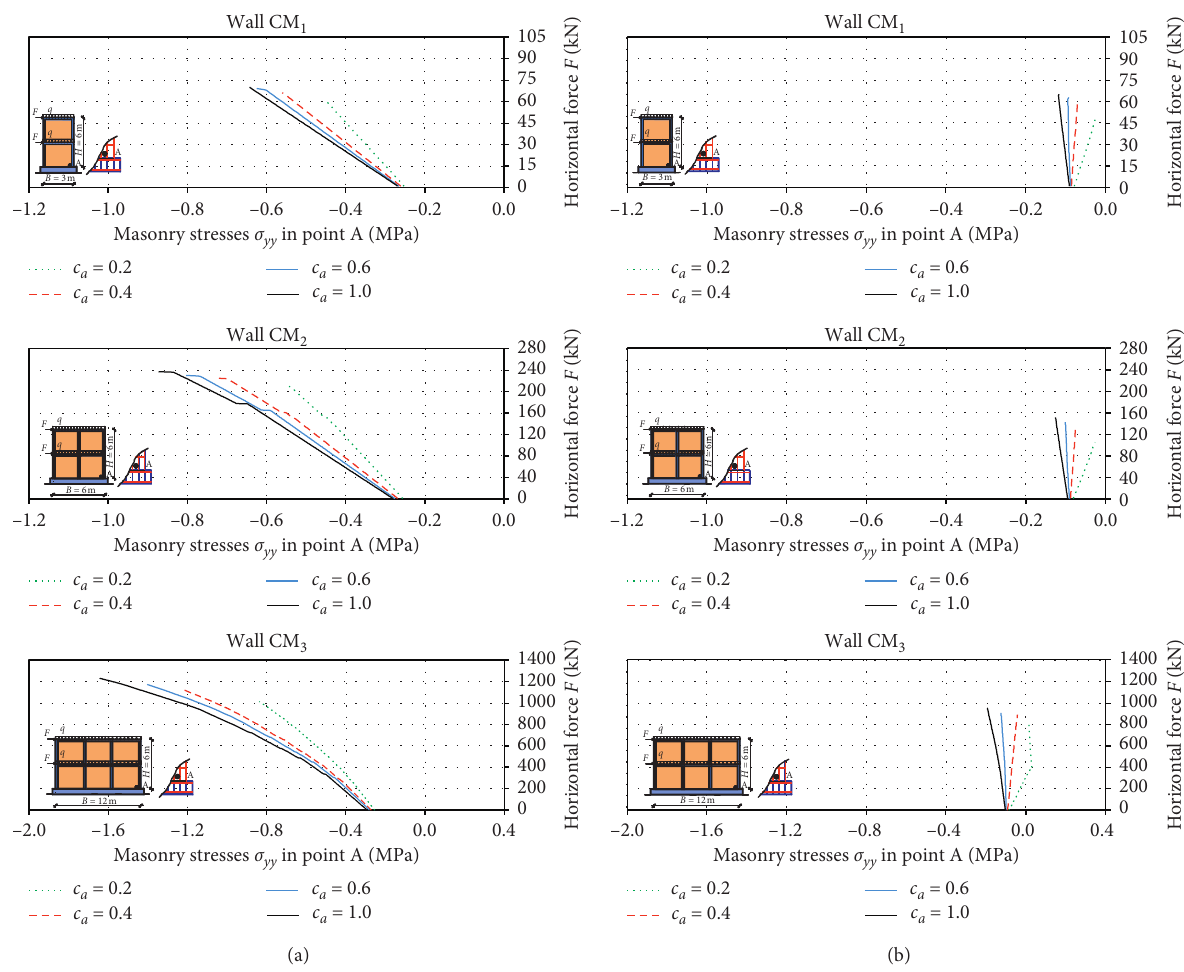
Figure 13: Vertical stresses in masonry in point A at the bottom of confined masonry walls: (a) stiff masonry; (b) soft